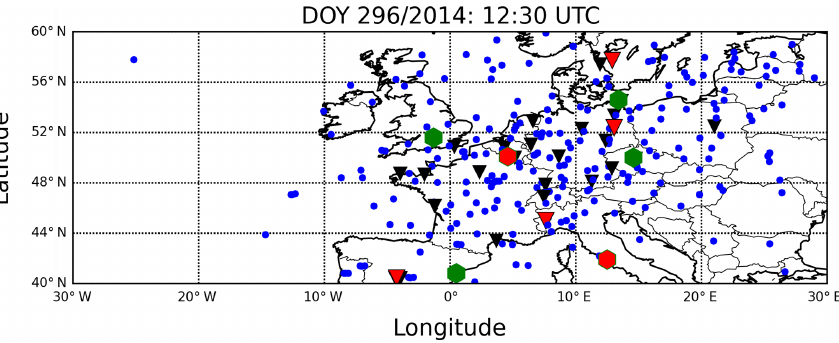
Figure 2. Typical measurement scenario over Europe for DOY 296/2014 using the IGS ground-station GNSS network and six ionosondes within Europe: IGS ground stations are depicted as triangles and ionosondes as hexagons. Stations in red are used for validation. Ionospheric piercing points of the GPS-based STEC measurements are shown as blue